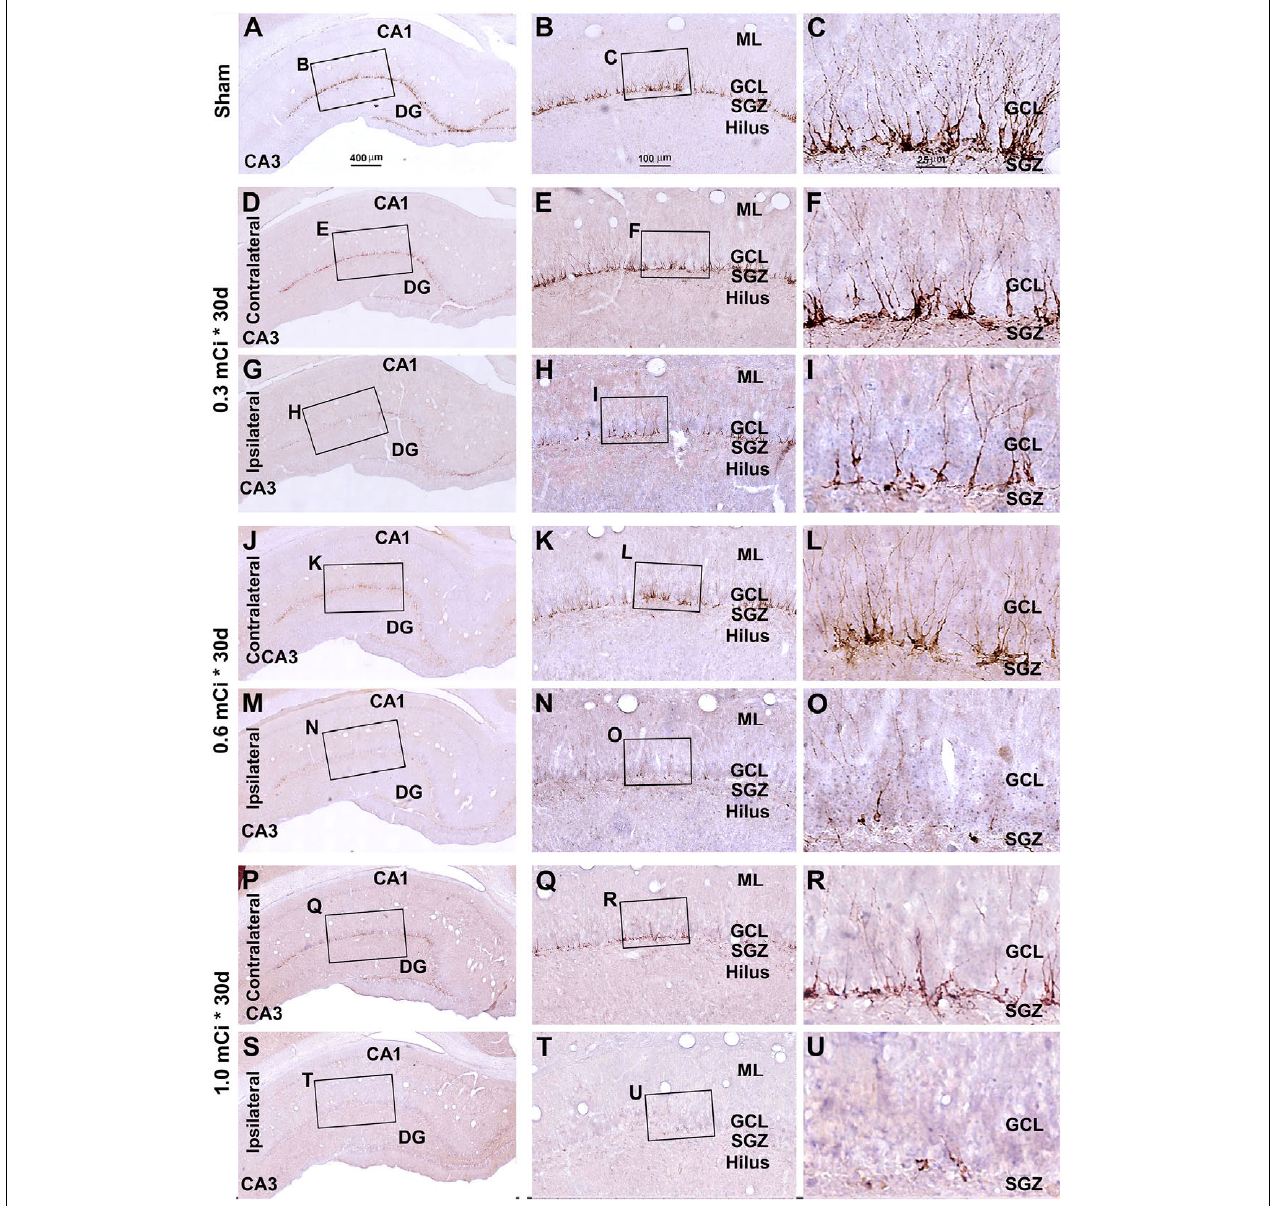
FIGURE 7 | Characterization of hippocampal immature neurons with immunolabeling of doublecortin (DCX) in ipsilateral and contralateral hippocampal dentate gyrus relative to shamed guinea pigs after 0.3–1.0-mCi 125 I seed radiation for 30 days. Representative images and enlarged areas of DCX immunolabeling (brown) with hematoxylin counterstain (blue) from individual animal groups are as indicated. The left panels are low-magnification images showing the orientation of Ammon’s horn (CA1, CA3) and dentate gyrus (DG), with framed areas enlarged as the middle and right panels, as indicated. DCX + immature neurons are overwhelmingly localized to the SGZ, with labeled dendritic processes extending into the molecular layer (ML) (C) . DCX + cells of the radiation groups are reduced bilaterally, more prominent in the ipsilateral side (H,I,N,O,T,U) , relative to the sham group, and show a decrease in the amount of dendritic labeling of the radiated groups (H,I,N,O,T,U) . Abbreviations are as defined in Figure 2 . Scale bar = 400 µ m in (A) applying to (D,G,J,M,P,S) ; equal to 100 µ m for (B,E,H,K,N,Q,T) ; and 25 µ m for (C,F,I,L,O,R,U)